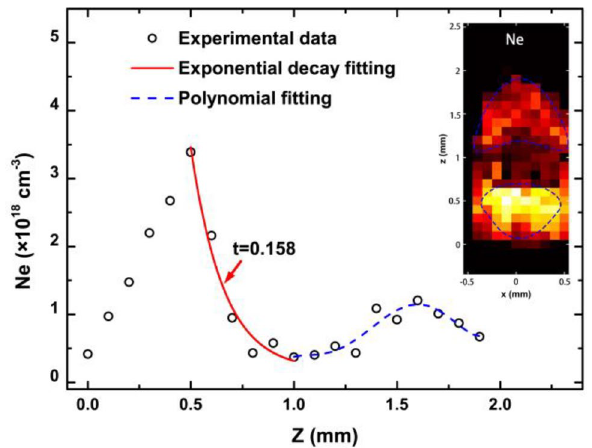
Figure 6. The electron density as a function of distance z; the inset shows the spatial distribution of the electron density in the